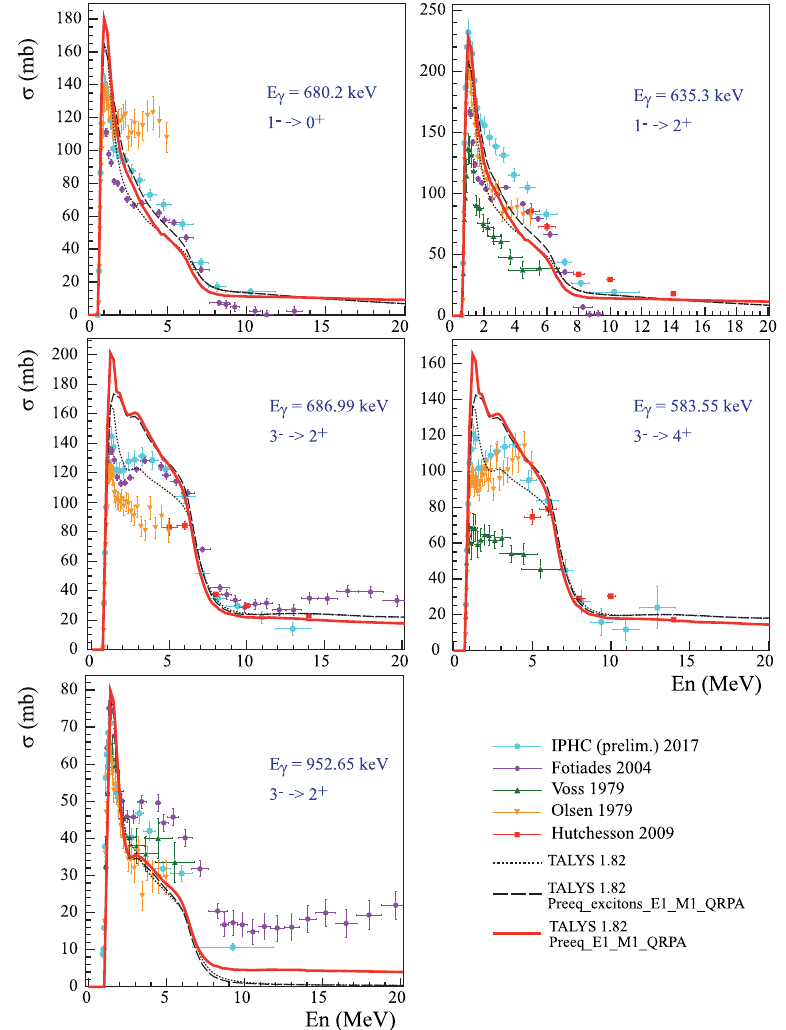
Fig. 10. Same as for Figure 8 but in the case of interband g